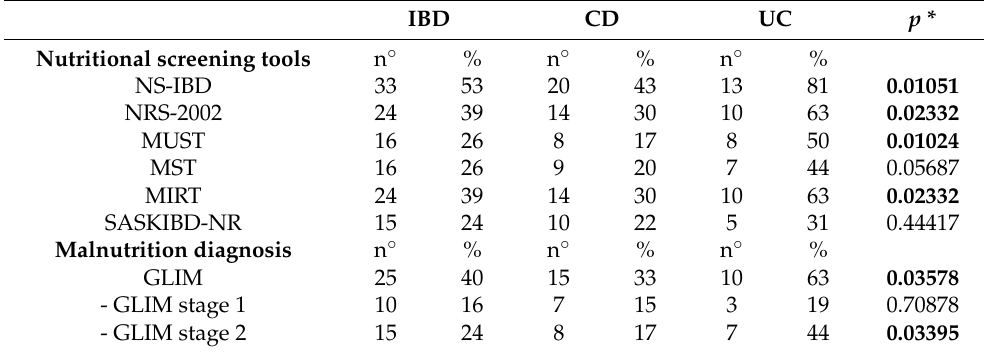
Table 4. Prevalence of high nutritional risk and malnutrition diagnosis in IBD, CD and UC patients.